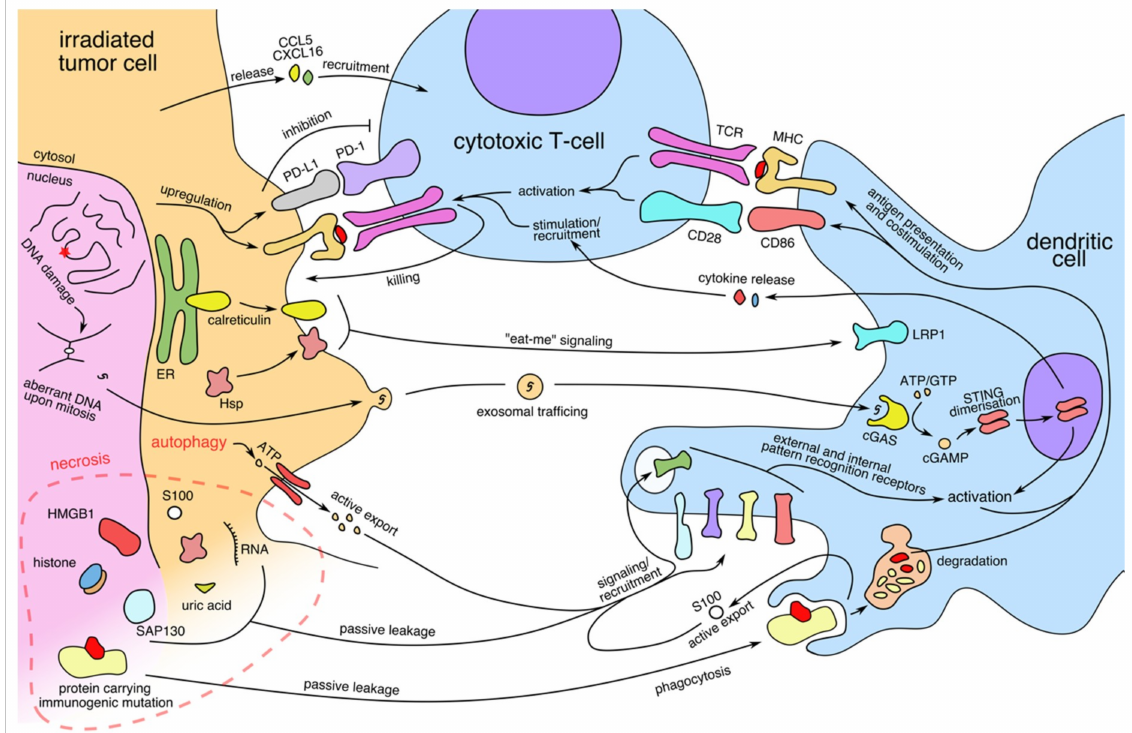
Figure 1. Immunomodulatory consequences of irradiation of tumor cells on dendritic cells and cytotoxic T-cells. Irradiation induces DNA damage, autophagy, and necrosis in the irradiated cells. This leads to stimulation of dendritic cells by danger-associated molecular patterns (DAMPs) mediated by various pathways. Antigen presentation by dendritic cells leads to activation of cytotoxic T-cells which can be blocked by immune checkpoint molecules expressed by tumor